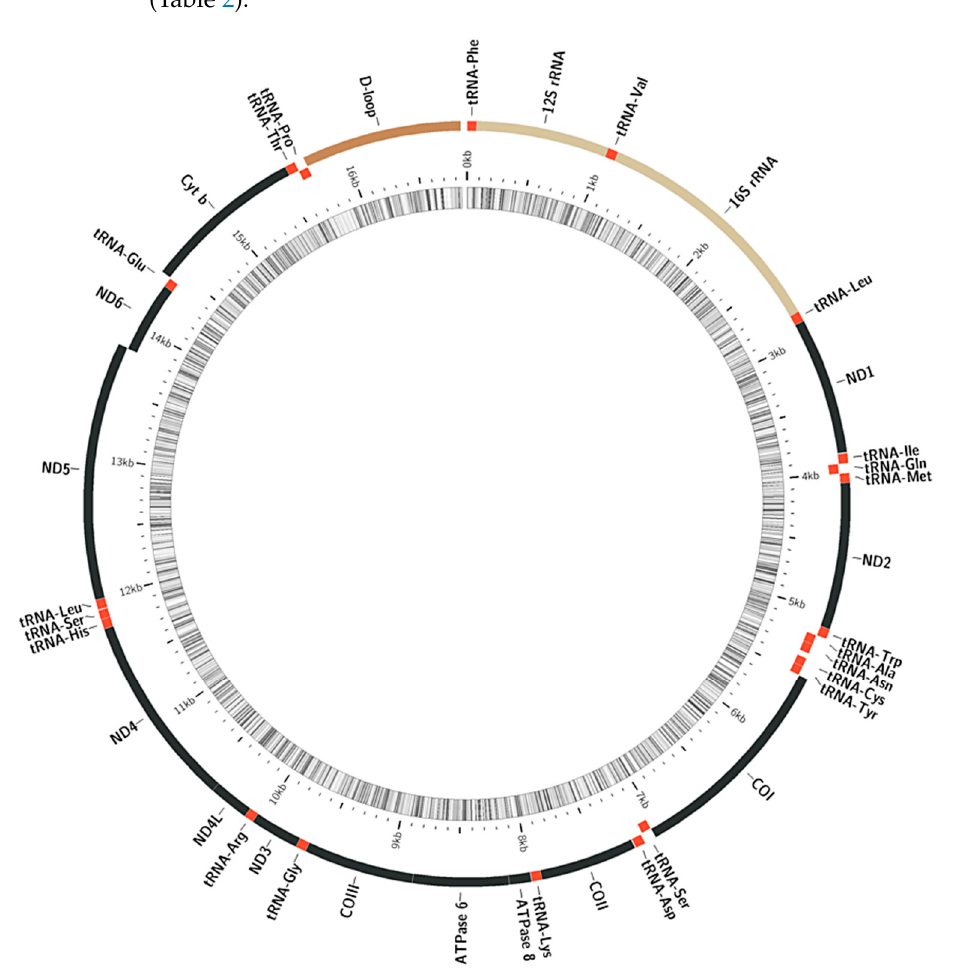
Figure 1. Map of the circular mitochondrial genome of the yellow-stripe flounder Pseudopleuronectes herzensteini. The external ring displays the abbreviations and composition for the main components of the mitogenome. It includes: 13 protein-coding genes (ATPase6, ATPase8, COI, COII, COIII, Cyt-b, ND1, ND2, ND3, ND4, ND4L, ND5, and ND6), 2 rRNA genes ( 12S rRNA and 16S rRNA), and 22 tRNA genes (tRNA-Val, -Leu, -Ile, -Met, -Trp, -Ala, -Asn, -Cys, -Tyr, -Ser, -Asp, -Lys, -Gly, -Arg, -His, -Ser, -Leu, -Glu, and -Pro). Shifted inside line display the components of the genome located in the “ − ”-chain. Most genes are located in the “+”-chain. Inside ring mapping, the whole mitogenome length (kb), spanning orientation, and its longevity. Table 2. Mitochondrial genome information on two flatfish sequences presented in the current pa- per ( P. herzensteini and P. stellatus ) and the third ( P. yokohamae ), retrieved from GenBank.